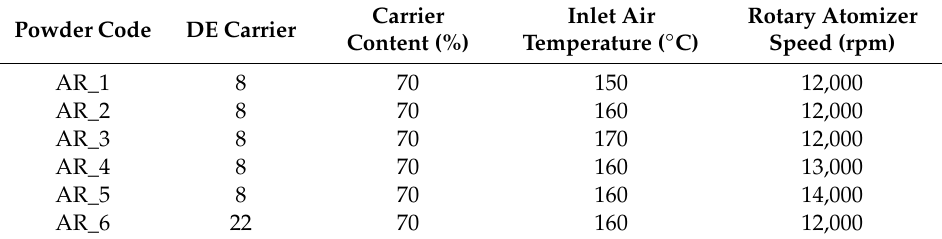
Table 1. Experimental conditions used for the spray-drying of chokeberry juice with a